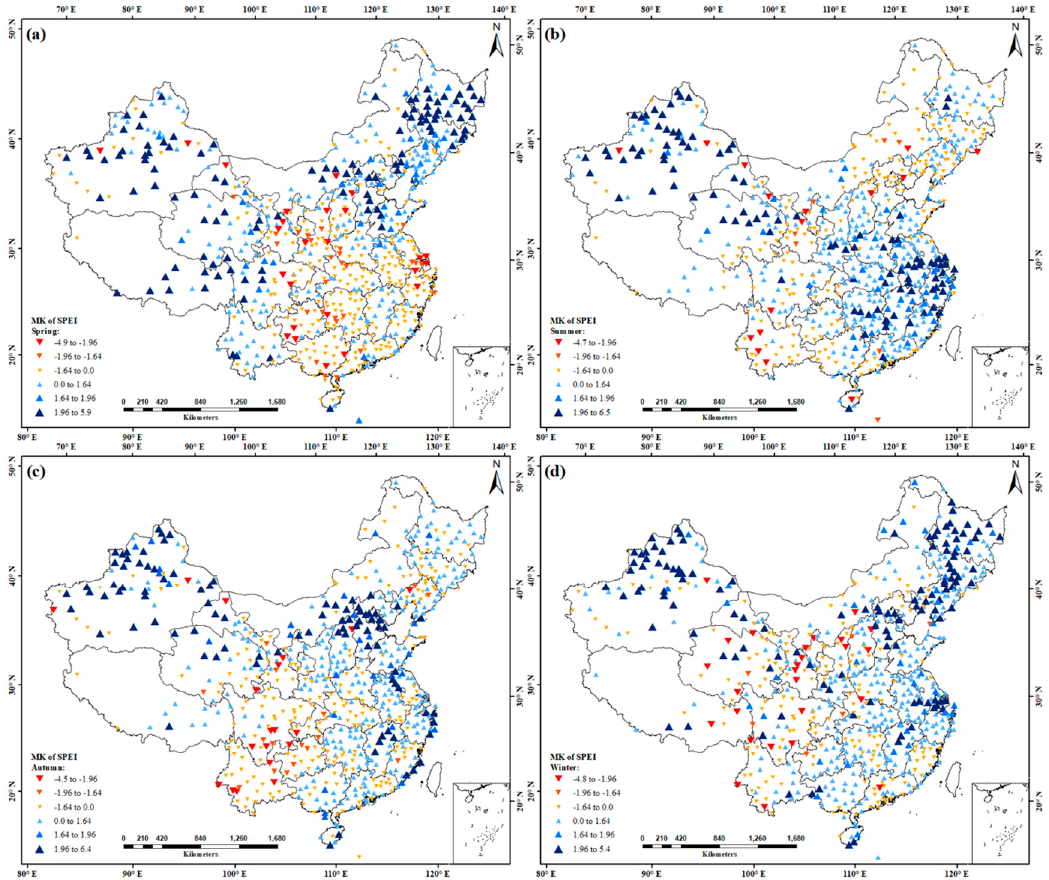
Figure 5. Spatial distribution of seasonal trends in the standardized precipitation evapotranspiration index (SPEI) from 1965 to 2017: ( a ) spring, ( b ) summer, ( c ) autumn, and ( d ) winter SPEI. Triangles of different sizes indicate trends of different magnitudes. MK, Mann–Kendall test.